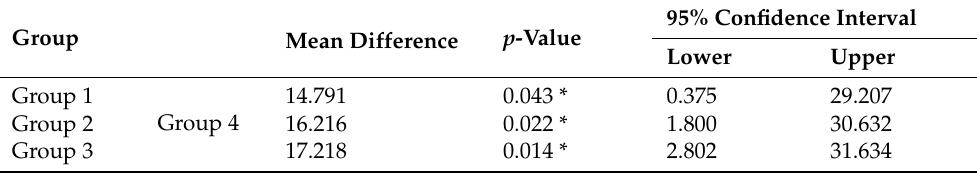
Table 4. Multiple comparisons test for